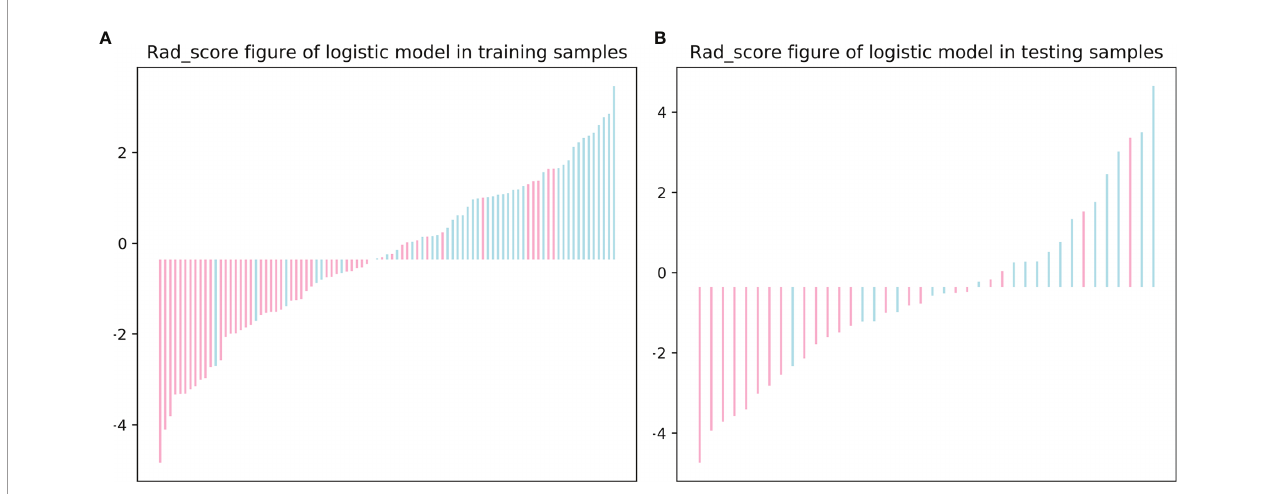
FIGURE 5 | The radiomics score (Rad-score) for each patient in the training (A) and testing (B) sets.